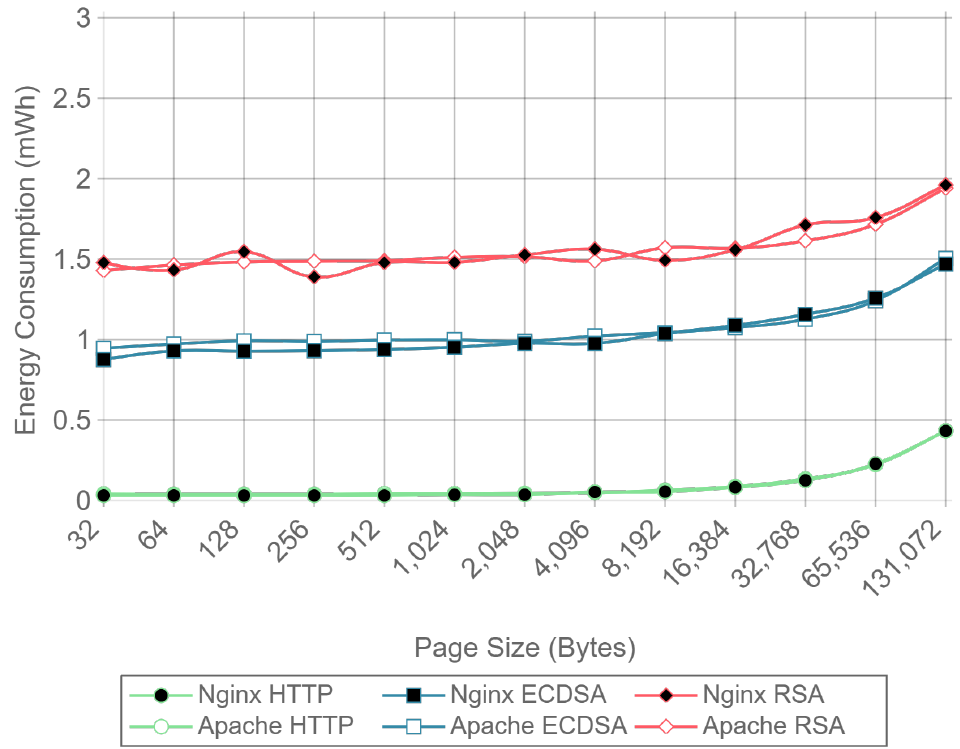
Figure 16. Client-side page size versus energy consumption for Apache2 and Nginx with two concurrent